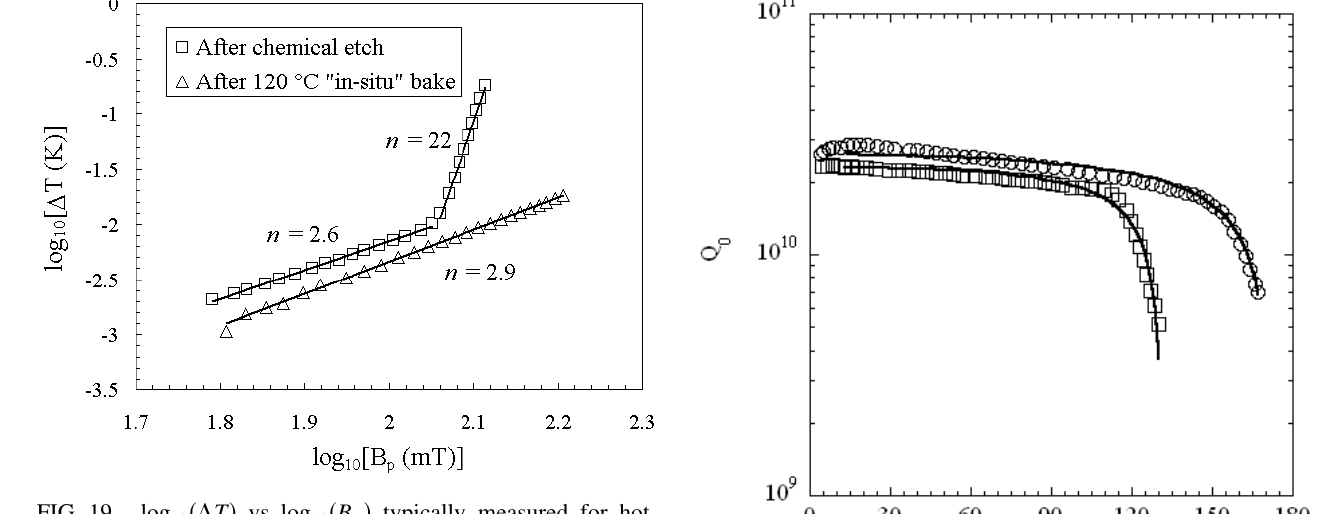
(cid:1) (cid:2) T (cid:2) vs log (cid:1) B (cid:2) typically measured for hot 19. log p 10 10 spots after a chemical etch of the cavity and after 120 (cid:3) C in situ baking. Solid lines represent linear fits with the indicated values of the slope, n